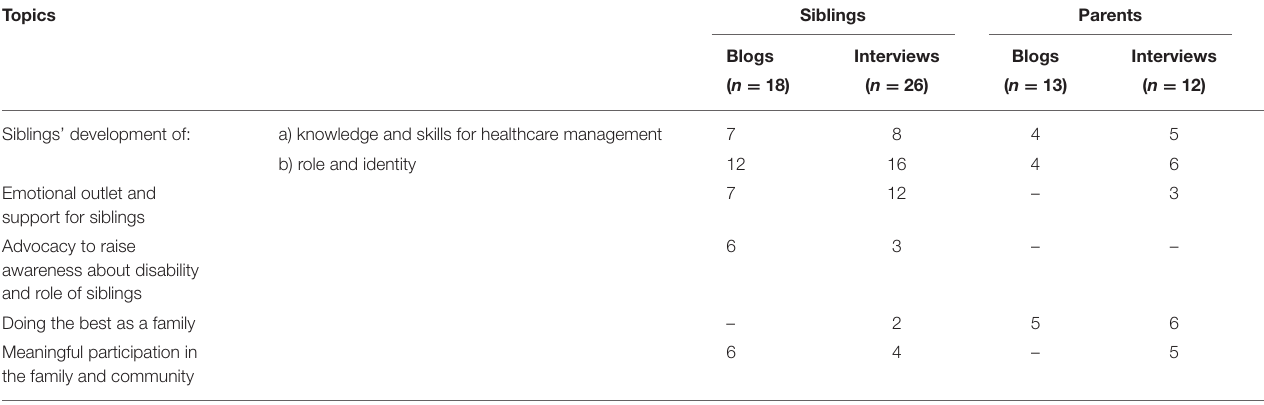
TABLE 2 | Frequency of topics identified in interviews and blogs with parents and